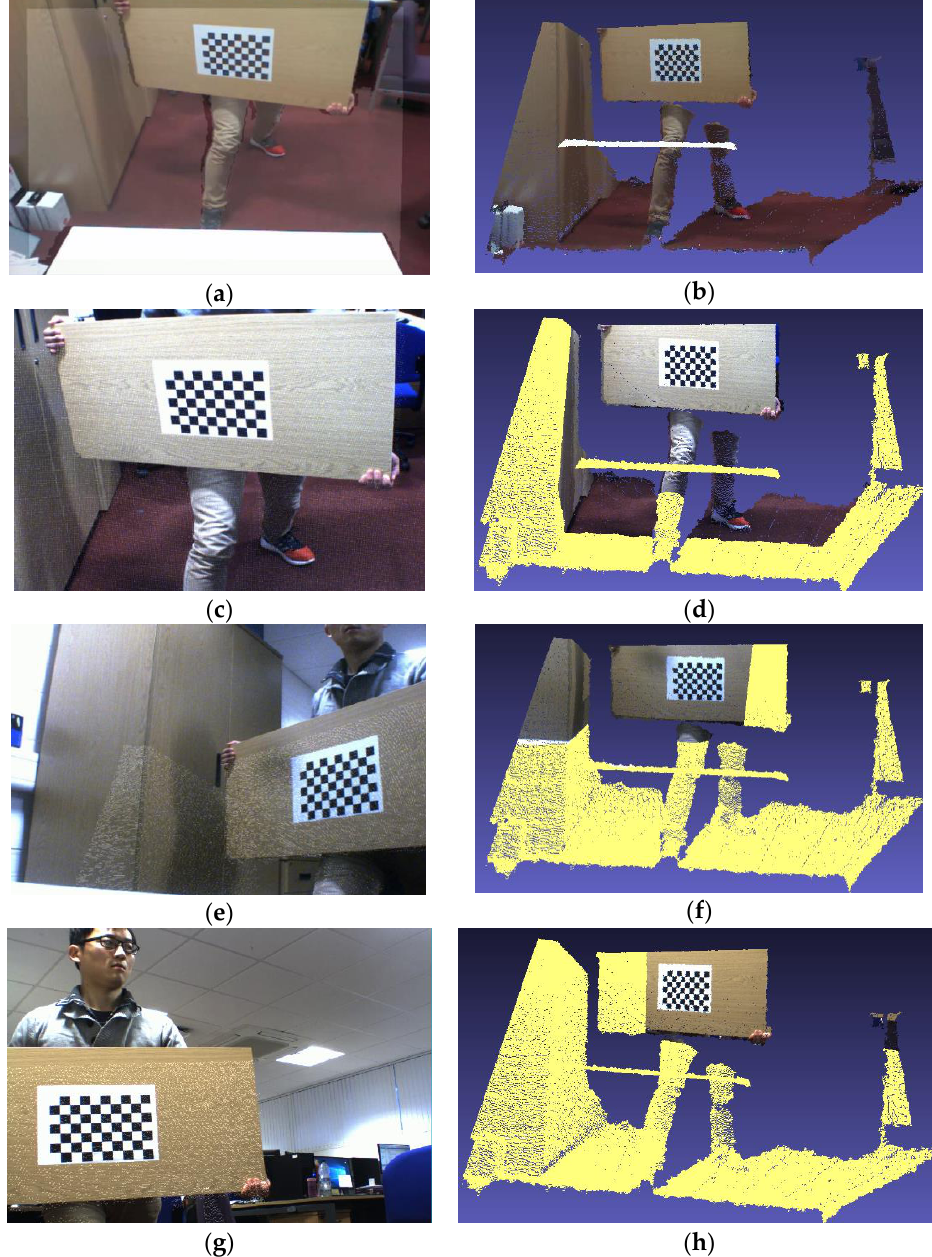
Figure 6. The overlaid depth maps and the corresponding 3D colored point cloud images obtained by proposed method. ( a ) the color image is captured by the color camera in Kinect; ( c ), ( e ), ( g ) the color images are captured by the external camera 0, 1 and 2, respectively; ( b ), ( d ), ( f ), ( h ) are the corresponding 3D colored point cloud images, and they are captured from ( a ), ( c ), ( e ), ( g ), respectively.